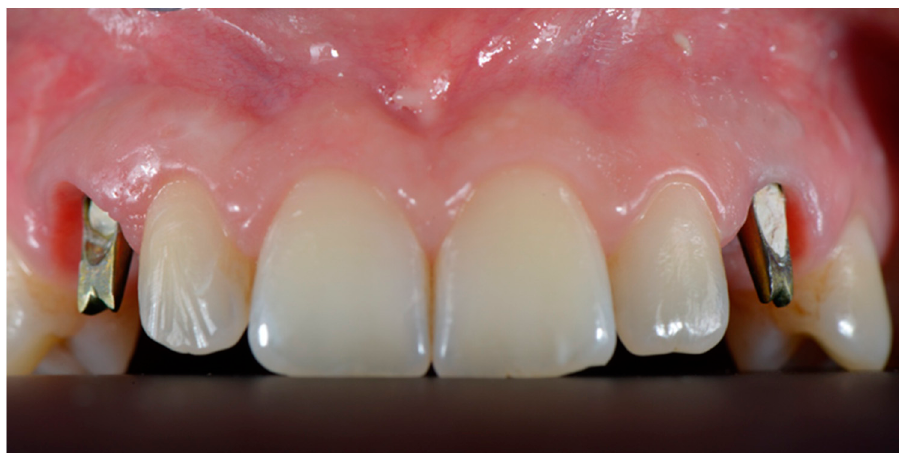
Figure 5. Definitive CAD-CAM milled abutments.